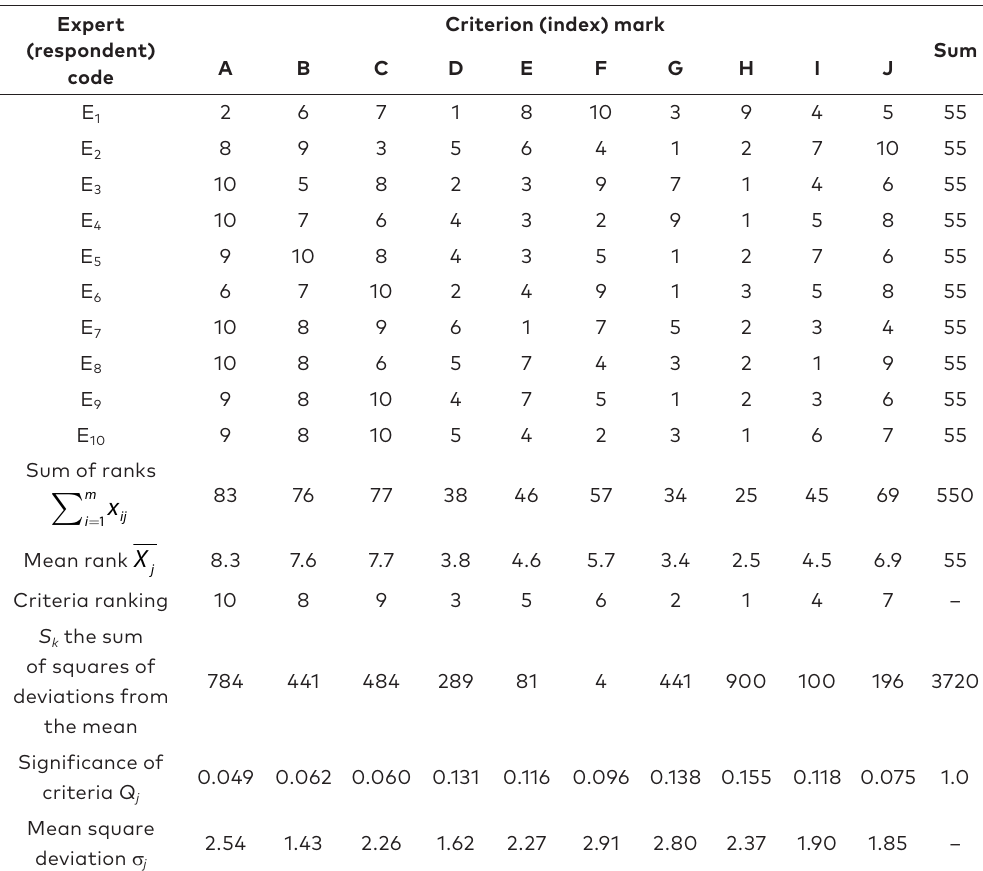
Table 2. Results of criteria significance scores of rest areas and stopping places (compiled by the authors,